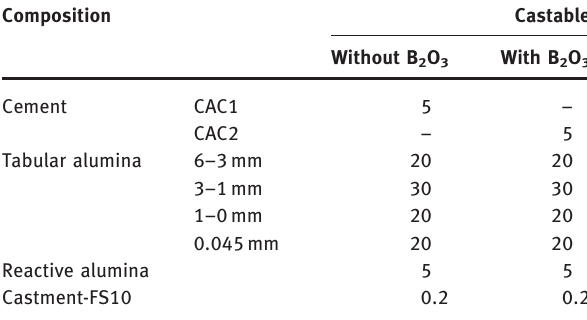
Table 3: Compositions of CAC-bonded corundum-based castables (wt%).